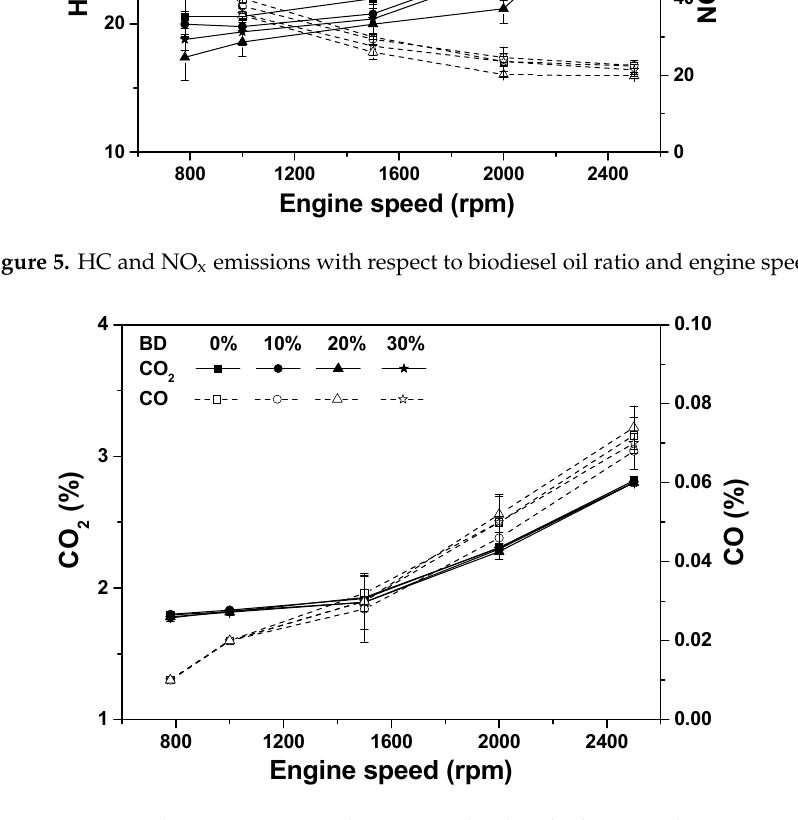
Figure 6. CO 2 and CO emissions with respect to biodiesel oil ratio and engine speed.